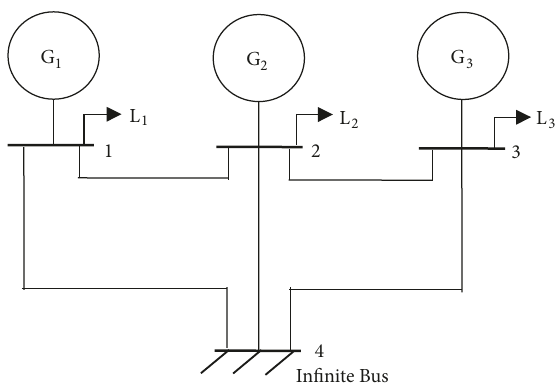
Figure 1: Three-machine infinite bus power